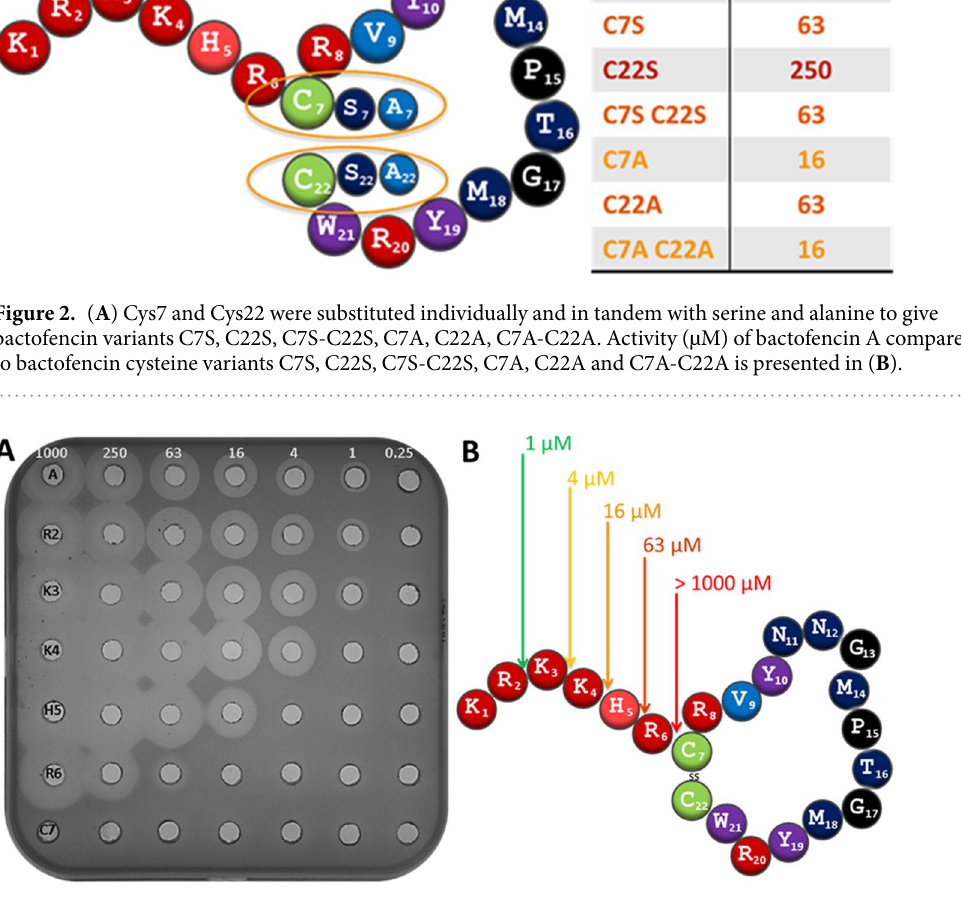
Figure 3. ( A ) Activity ( µ M) of bactofencin A and deletion variants, R2-C22, K3-C22, K4-C22, H5-C22, R6-C22 and C7-C22 against S . aureus DPC5246. ( B ) Activity ( µ M) of bactofencin A and deletion variants against S . aureus DPC5246. Activity is colour coded with green being most active and red